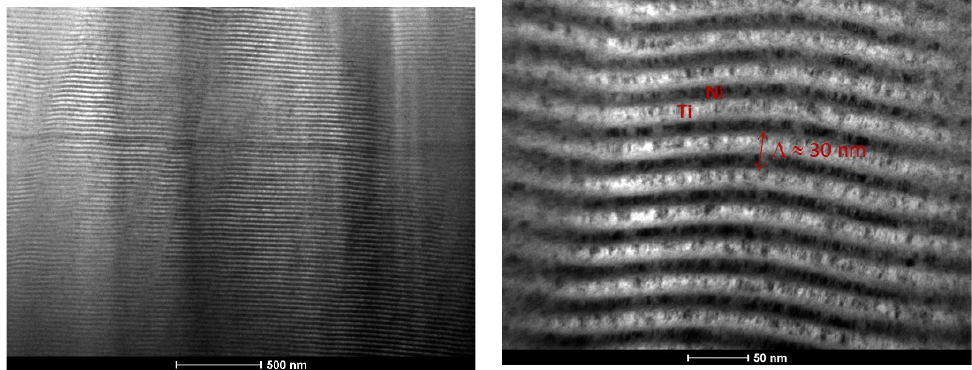
Figure 4. BF TEM cross-section micrographs of Al/Ni thin films with ( a ) Λ ≈ 25 nm, and ( b,c) Λ ≈ 45 nm deposited onto W wires ( φ = 0.20 mm). SAED patterns and respective indexation of the Al/Ni thin film with Λ ≈ 45 nm in zones ( d ) without, and ( e ) with defects. In Figure 5, a BF TEM image of a Ni/Ti multilayer thin film with Λ ≈ 25 nm deposited onto a W wire ( φ = 0.20 mm) is shown.